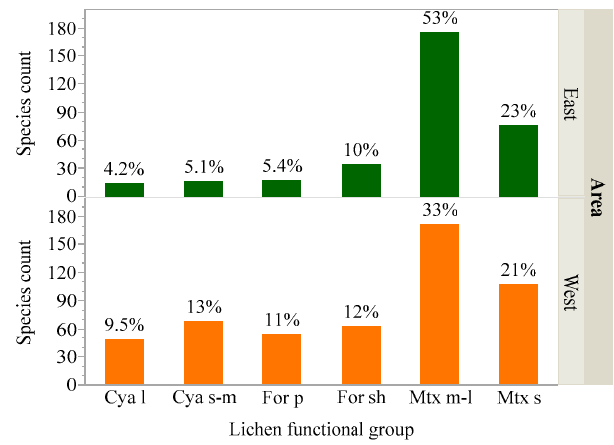
Figure 3. Species richness of matrix lichens was similar in the eastern and western US, but species richness of forage and cyanolichens was higher in the west. Forage and cyanolichens also comprised a higher percentage of western, compared to eastern, species. Values above bars indicate the percentage of species in that functional group for the East or West. Abbreviations: Cya = cyanolichen, For = forage lichen, Mtx = matrix lichen, l = large, s-m = small to medium, sh = shrubby, s = small, m-l = medium to large.